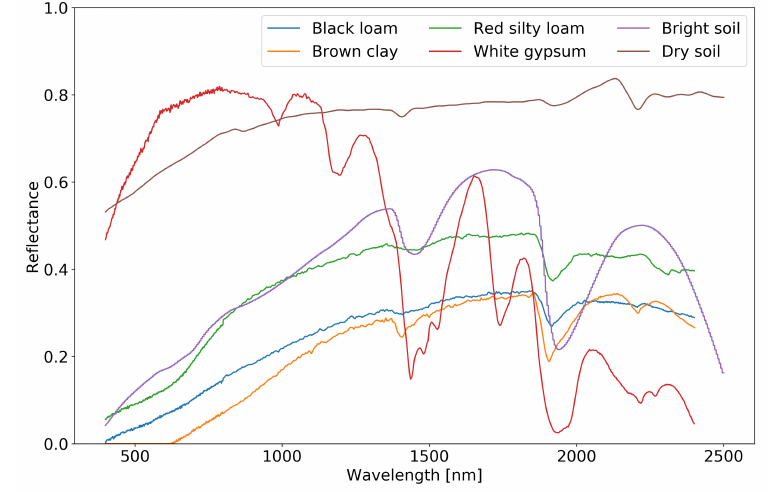
Figure 2. 6 soil spectra chosen to reflect varying absorption features taken from Baldridge et al. [24] and Price